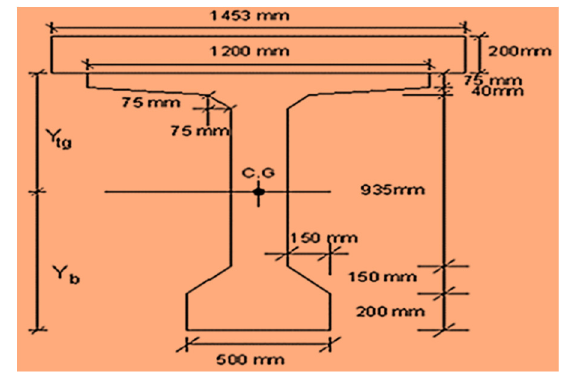
FIG. 6: T BEAM COMPOSITE SELECTED GIRDER